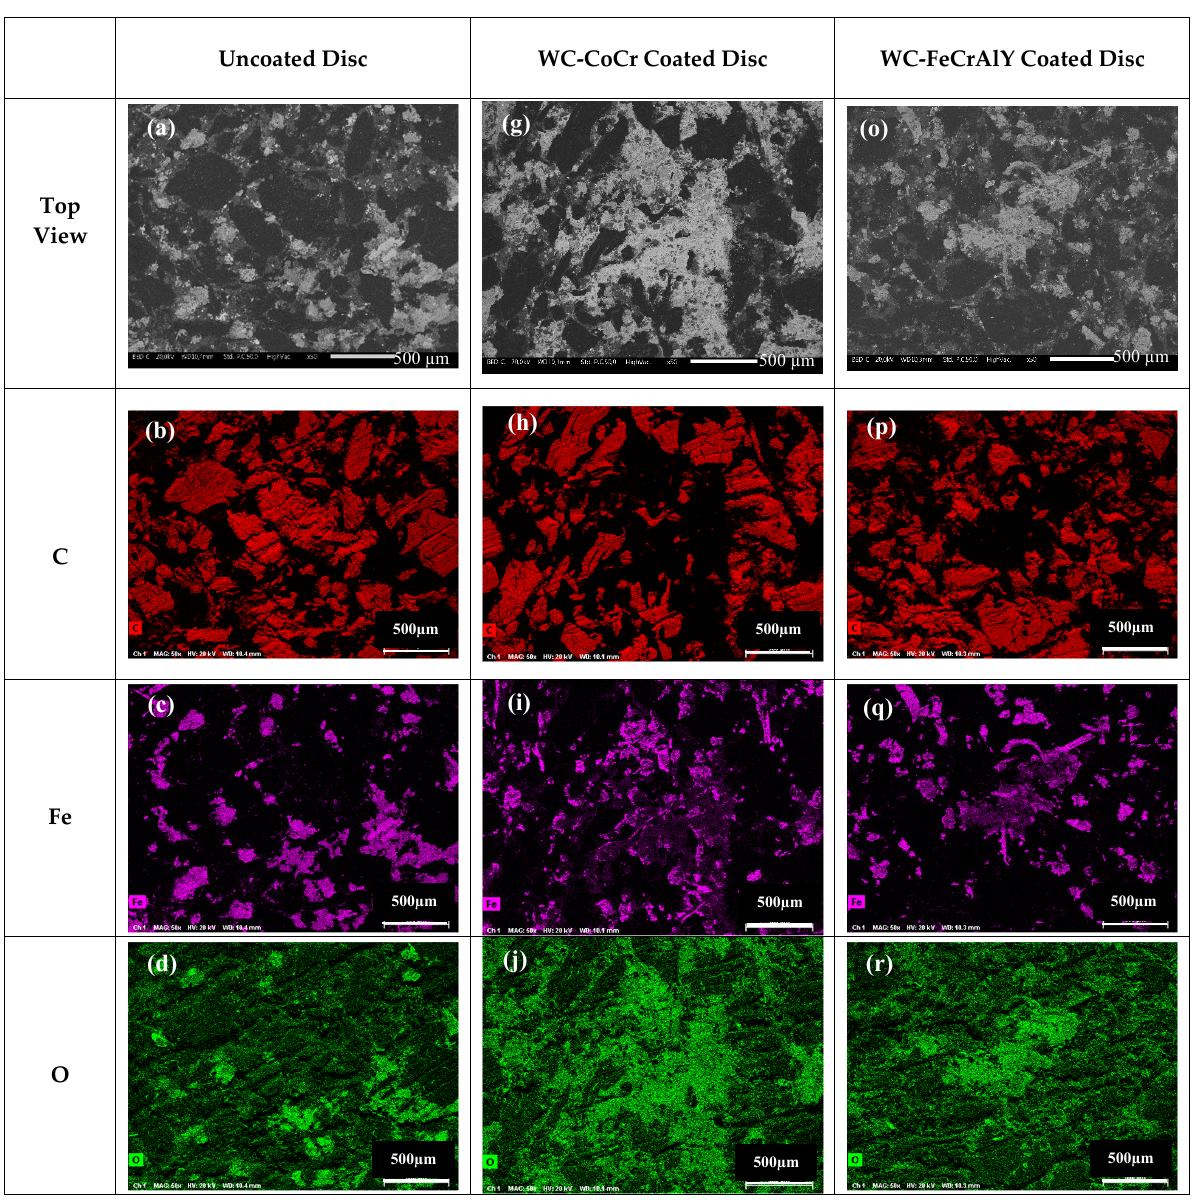
Figure 8. Comparison of the disc profiles of ( a ) uncoated martensitic stainless steel; ( b ) WC-CoCr- coated disc; and ( c ) WC-FeCrAlY-coated disc. The arrows indicate the contact length.